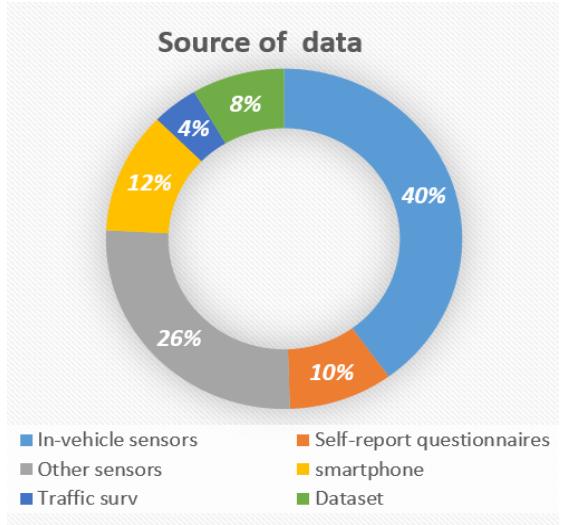
Figure 6. Collecting data sources used on literature